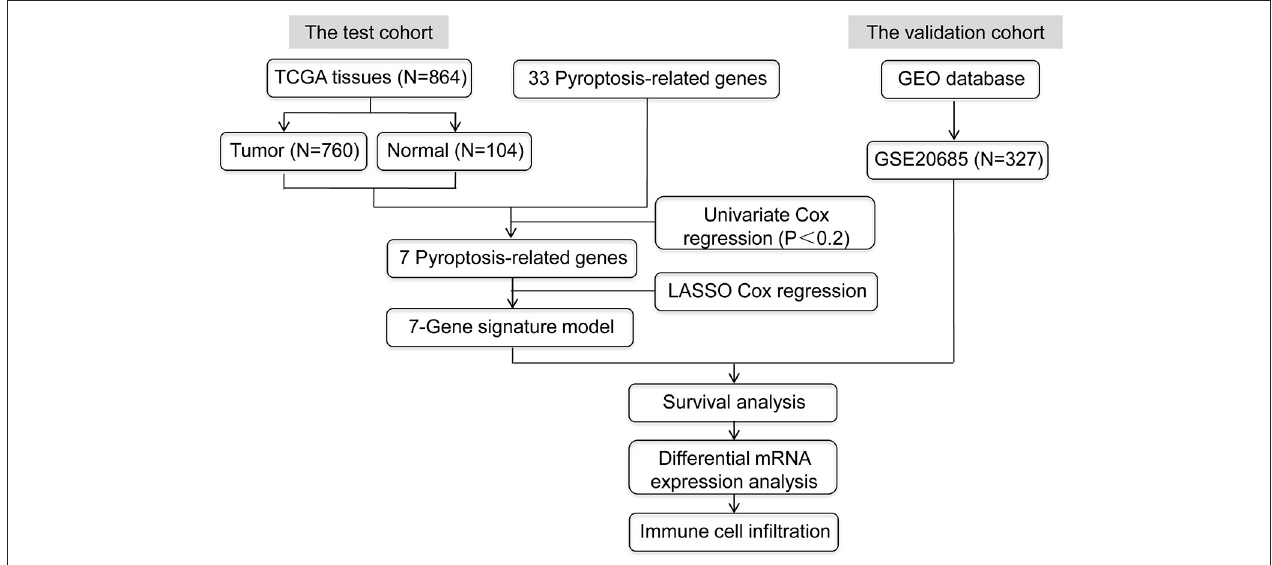
FIGURE 1 | The detailed flow diagram of overall procedures in this